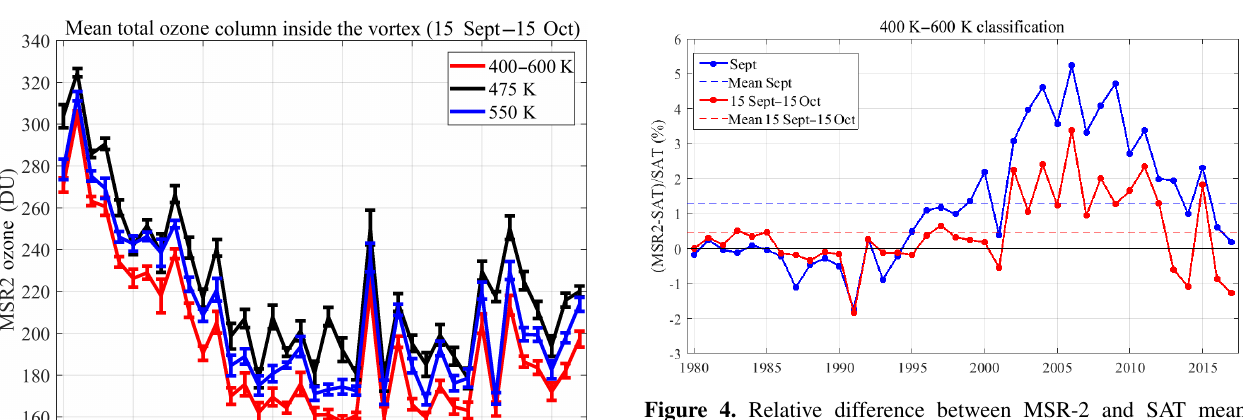
Figure 4. Relative difference between MSR-2 and SAT mean total ozone inside the vortex for September (blue curve) and 15 September–15 October (red curve) periods. Horizontal dash lines correspond to the mean bias between data